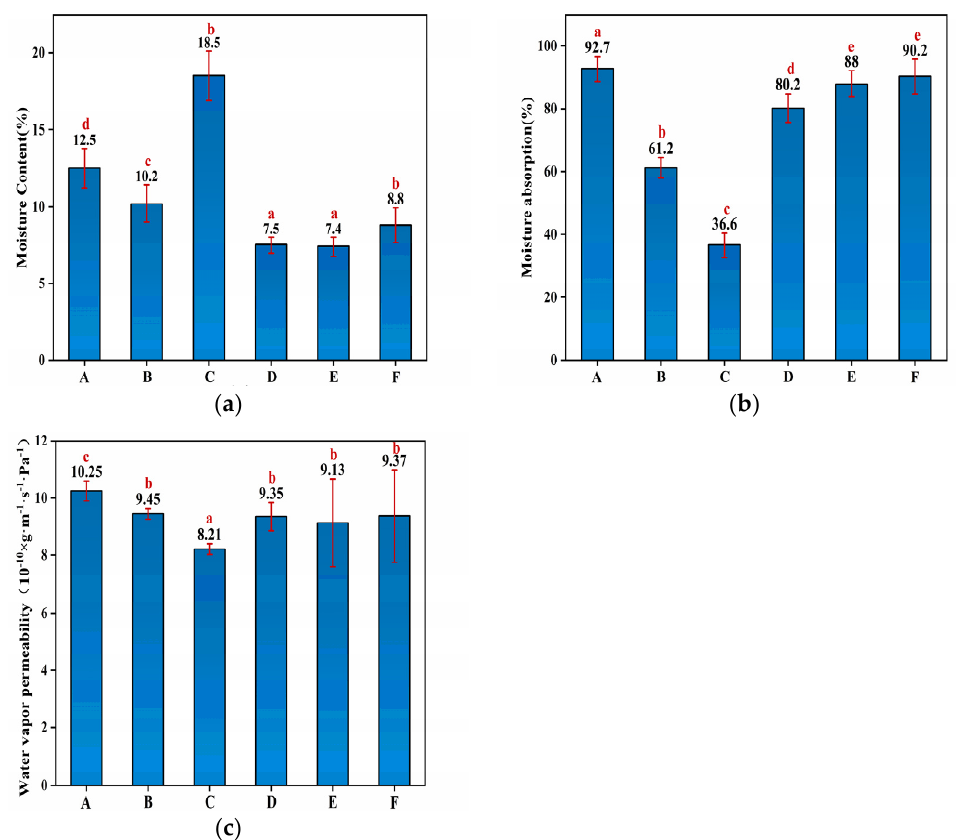
Figure 3. The ( a ) MC; ( b ) MA; ( c ) WVP of composite membrane samples of (A) starch–PVA; (B) HNTs/starch–PVA; (C) CNF/starch–PVA; (D) HNTs–CNF/starch–PVA; (E) HNTs–KH560–CNF starch–PVA; (F) HNTs–KH570–CNF